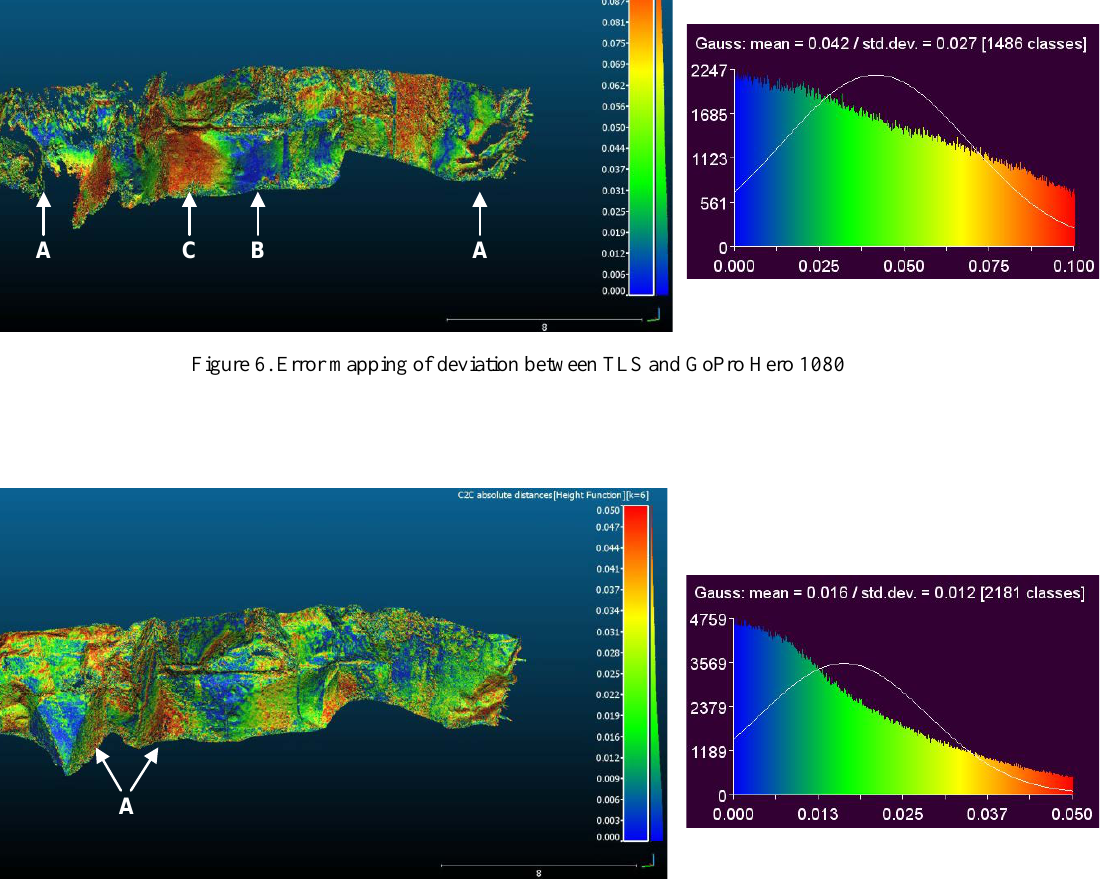
Figure 7. Error mapping of deviation between TLS and iPhone 4S